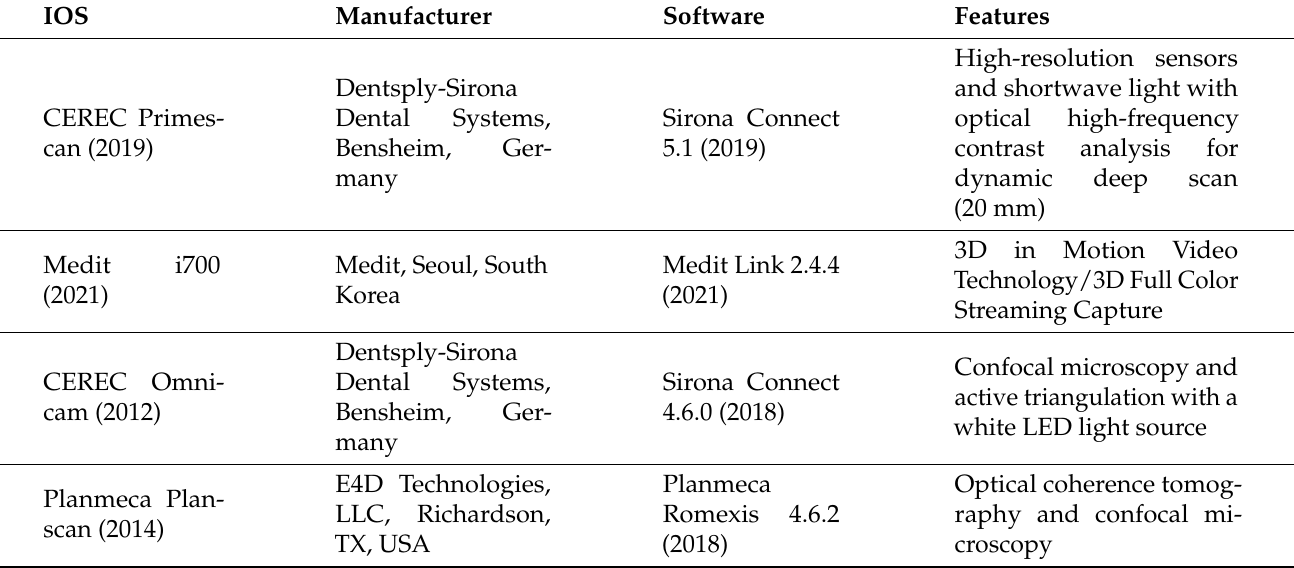
Table 1. Table displaying additional information about the selected